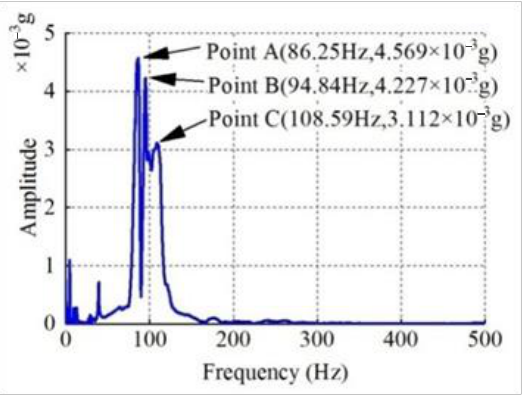
Figure 18. Natural frequency testing.